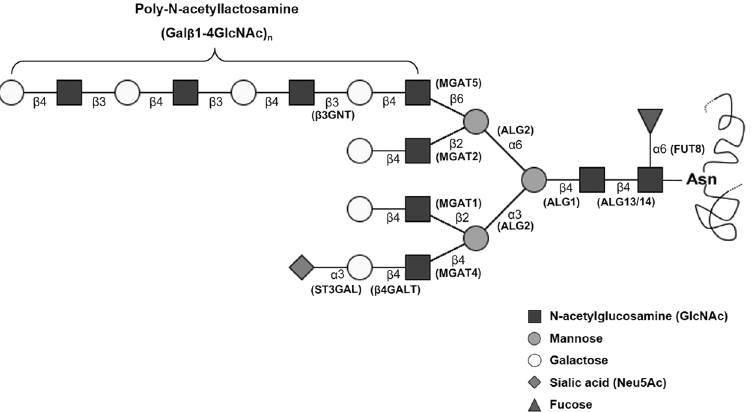
Figure 1. Schematic structure of a typical poly-LacNAc type N-glycan. Poly-N-acetyllactosamine (Poly- LacNAc) comprises repeated Gal β 1-4GlcNAc disaccharides, called N-acetyllactosamine (LacNAc). The biosynthesis of poly-LacNAc is accomplished by the enzymatic action of β -1,3 N-acetylglucosaminyltransferase ( β 3gnt) which catalyzes the addition of GlcNAc to N-glycan Gal termini. ALG, asparagine linked glycosylation gene, FUT, fucosyltransferase, MGAT, mannosyl-glycoprotein N-acetylglucosaminyltransferase, β 4GALT, beta-1,4 galactosyltransferase, ST3GAL, beta-1,4-galactoside alpha-2,3 sialyltranferase, β 3GNT, beta-1,3